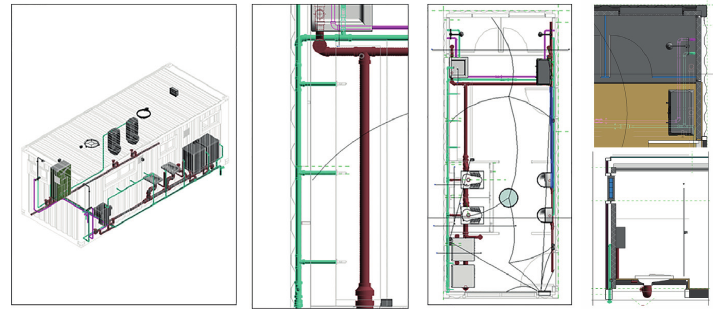
Figure 12: Comprehensive design of pipelines in bathroom based on